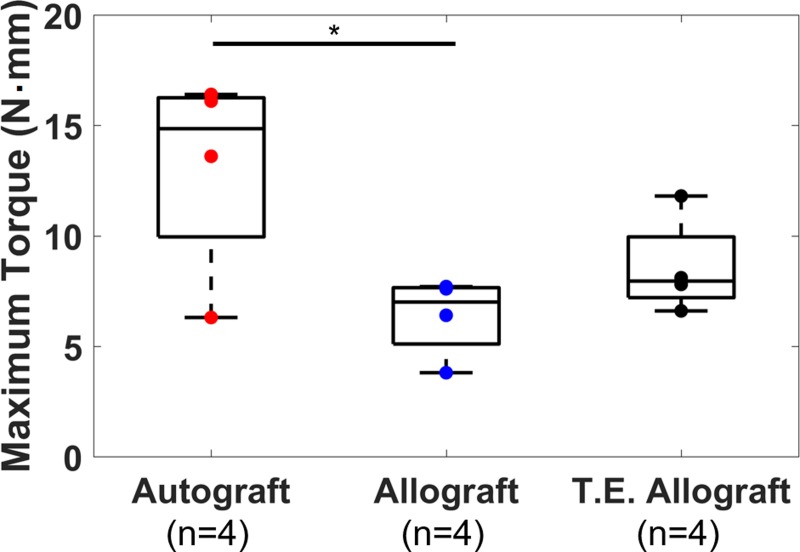
Maximum torque measured by biomechanical testing.* indicates that the difference between autograft group and allograft group is statistically significant.